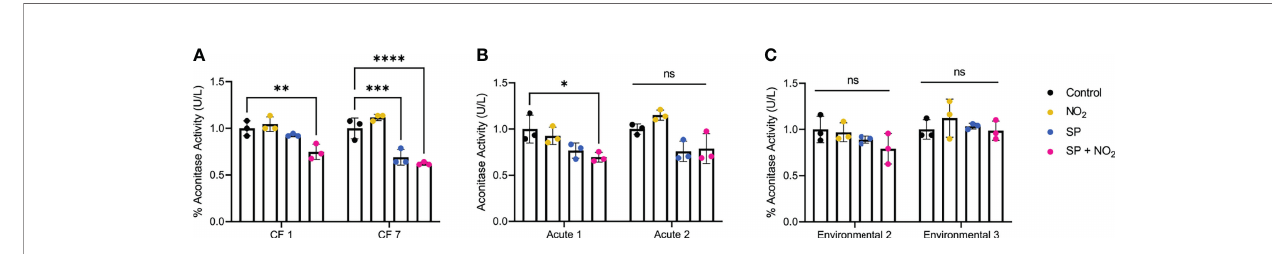
FIGURE 5 | Clinical isolates have reduced aconitase activity in the presence of reactive nitrogen intermediates. (A) Clinical, (B) acute, and (C) environmental isolates of P. aeruginosa were grown in the presence of nitrite, S. parasanguinis , or nitrite and S. parasanguinis. Aconitase activity was recorded and normalized to the average of controls. n=3, error bars represent standard deviation, ns, P>0.05, *P<0.05, **P<0.01, ***P<0.001, ****P<0.0001 (Two-Way ANOVA, Tukey post